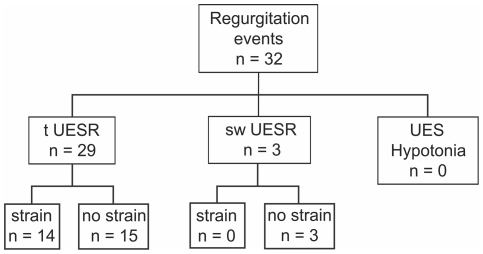
Relationships among esophago-pharyngeal, UES relaxations and strain.The majority of regurgitation events occurred during tUESRs. Abdominal strain can be a factor in regurgitation, but only in the context of a pre-existing UES relaxation. UES hypotonia alone is not an apparent risk factor for regurgitation.